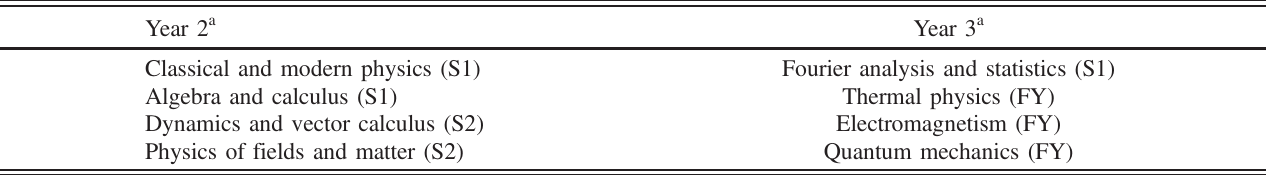
TABLE VI. Compulsory courses: Direct (second year)